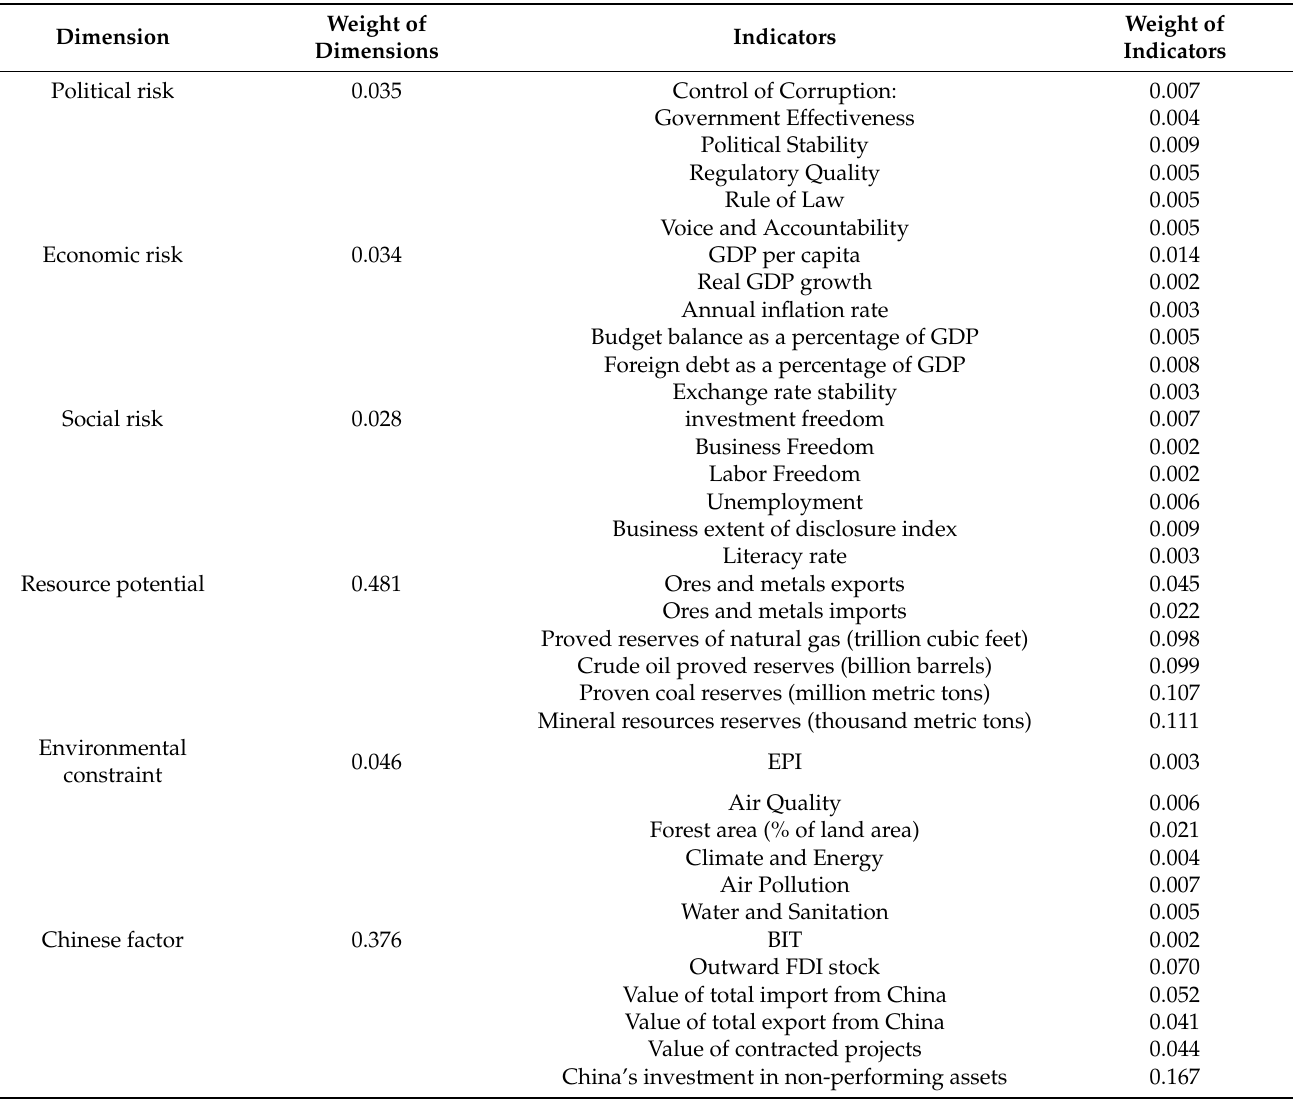
Table 4. Evaluation criteria system for mining investment risk under the